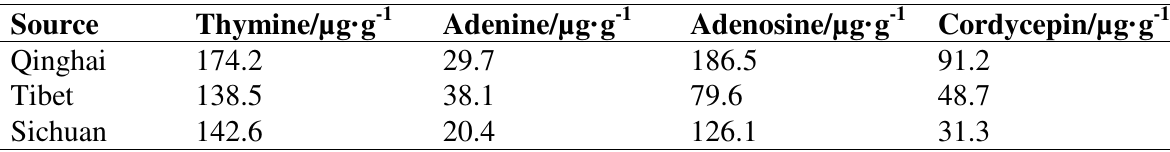
Table 5. Results for the determination of main nucleosides in Cordyceps sinensis from different